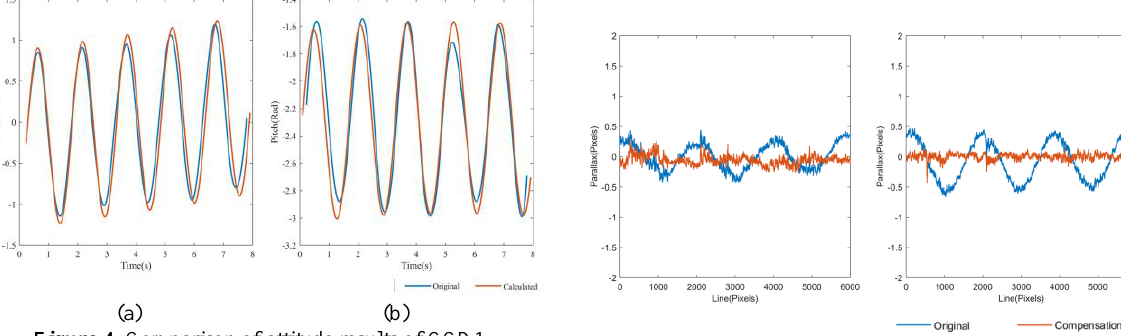
Figure 7 . CCD1 parallax of B1and B2 before and after jitter compensation ( (a) is the along-track direction parallax (b) is the cross-track direction parallax)